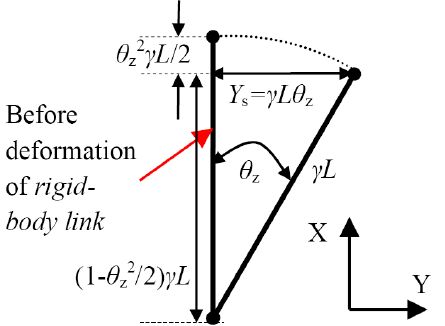
Figure 3. Kinematics schematic diagram of bending about z axis of a fixed-fixed